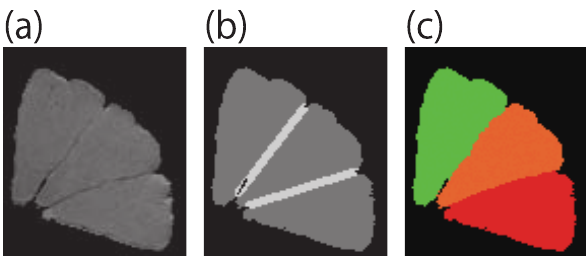
Figure 10. Sections of orange (a) is the input CT image. The white areas in (b) are the ROIs. (c) is the result of the proposed method.